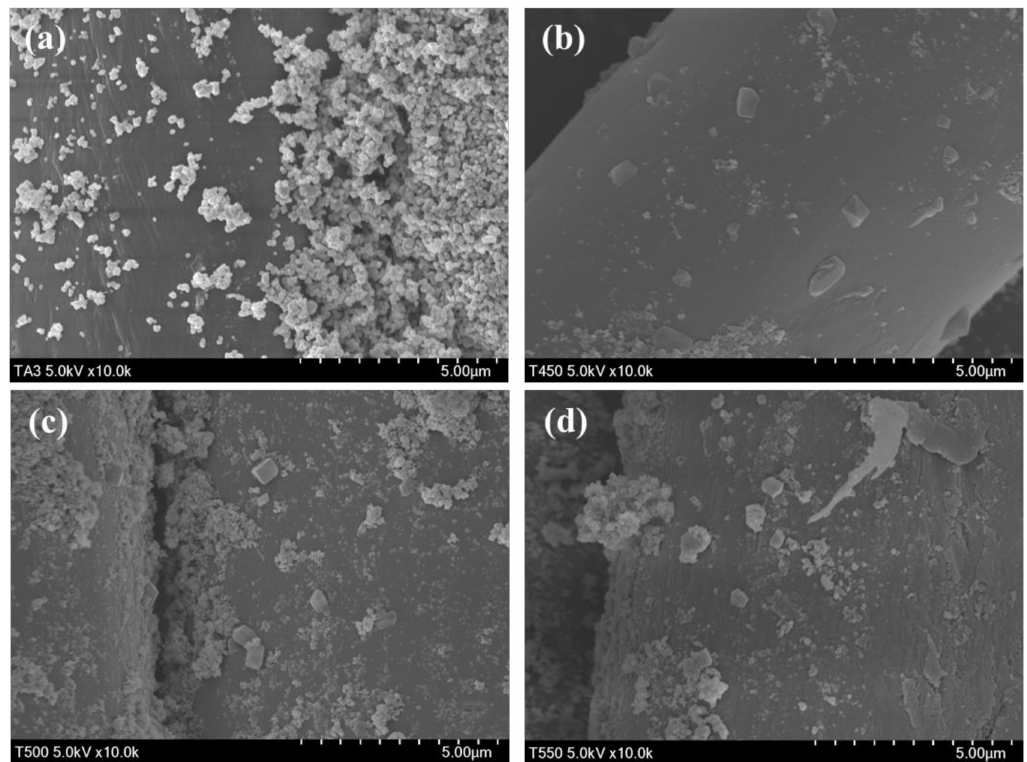
Figure 3. Morphologies of the prepared photocatalyst-treated PET fabrics; ( a ) aT, ( b ) 450TF, ( c ) 500 TF, and ( d ) 550